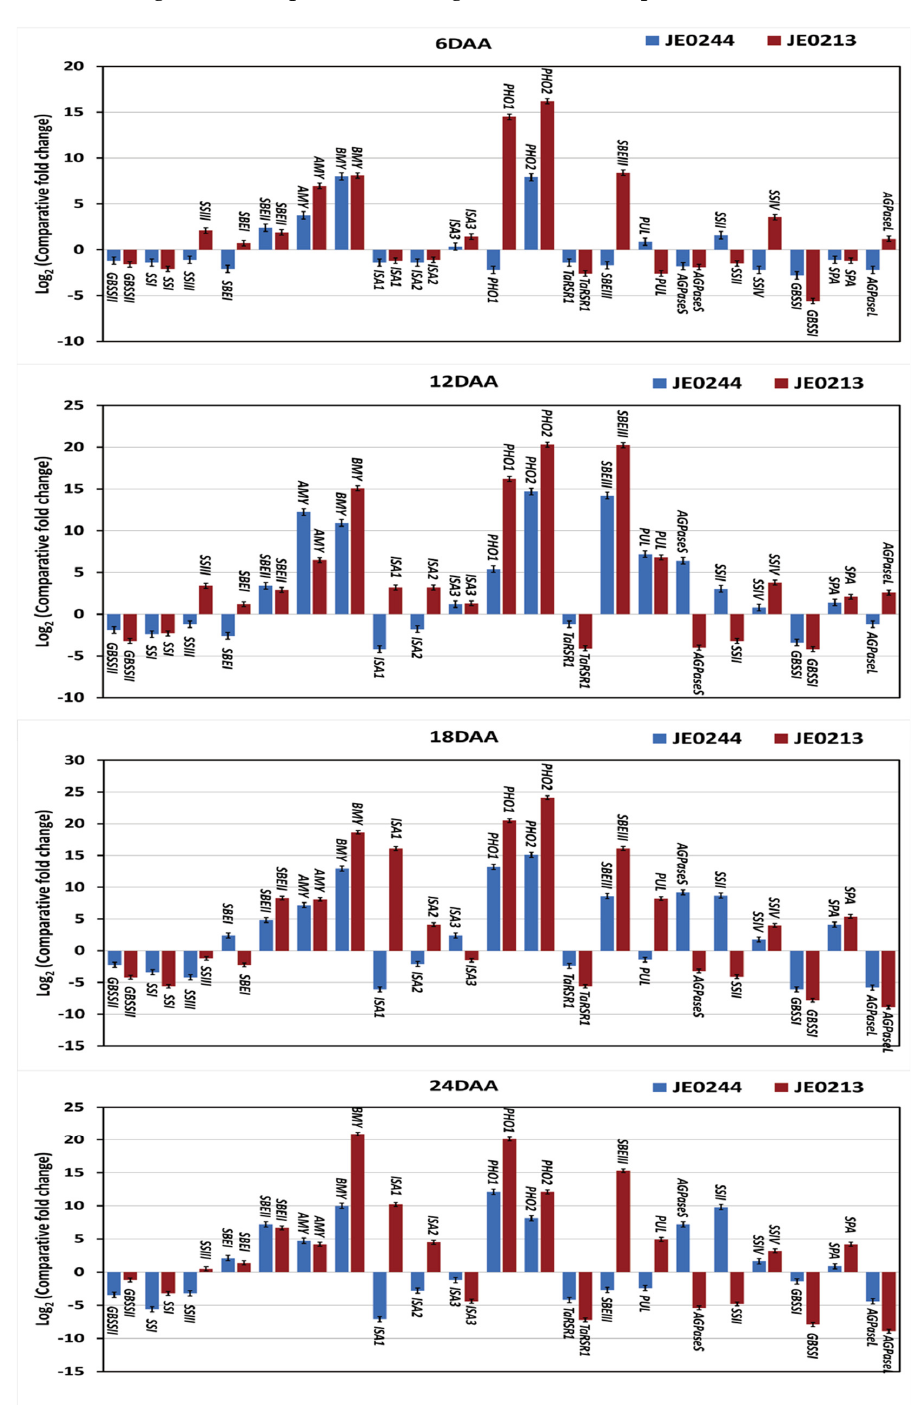
Figure 6. Real-time quantitative expression data (Log2 of fold change) of 19 starch metabolic genes during the seed development in the low starch mutant lines, ‘JE0089 and JE0418’, in comparison to the parent variety, ‘J411’. The seed development stages were 6, 12 18, and 24 days after anthesis (DAA). All the data are represented as mean ± SD from two biological and three technical replicates.